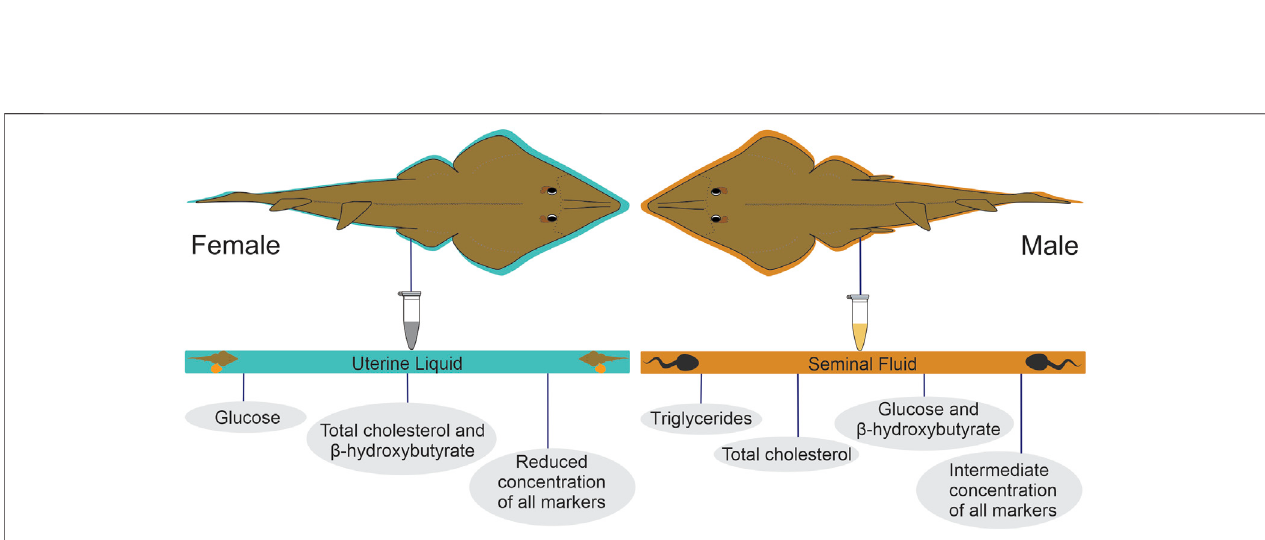
FIGURE 6 | Metabolite provisioning patterns observed in the uterine liquid of pregnant females and in the seminal fl uid of sexually active males of P. horkelii .